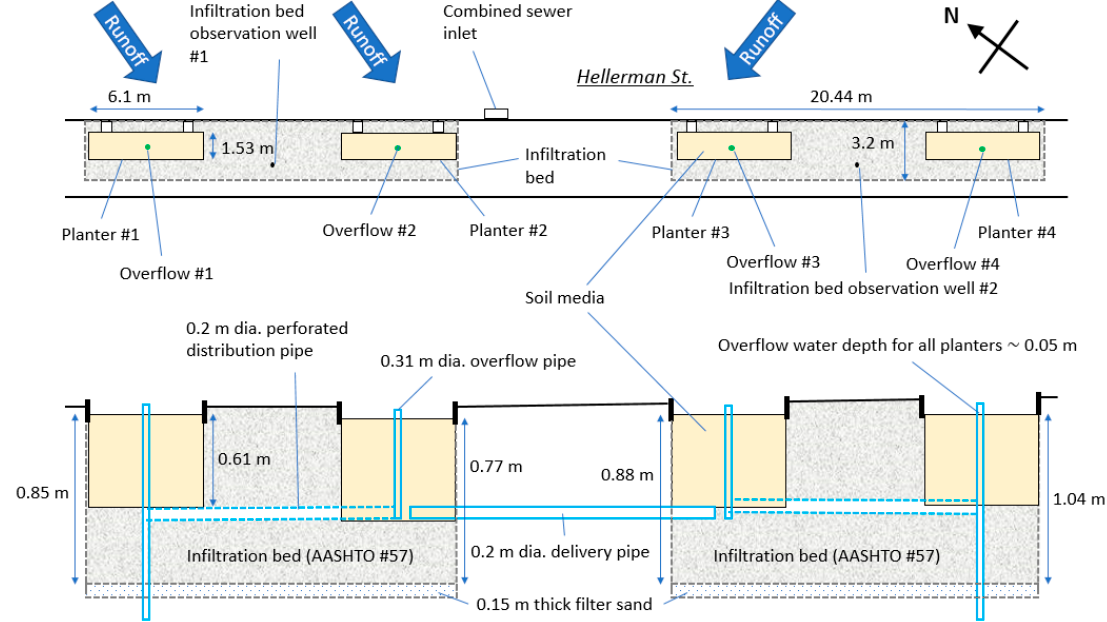
Figure 2. Plan view ( top ) and cross-section view ( bottom , vertical scale exaggerated) of the green infrastructure sidewalk planters (adapted from Tu and Traver [22] with permission from ASCE).